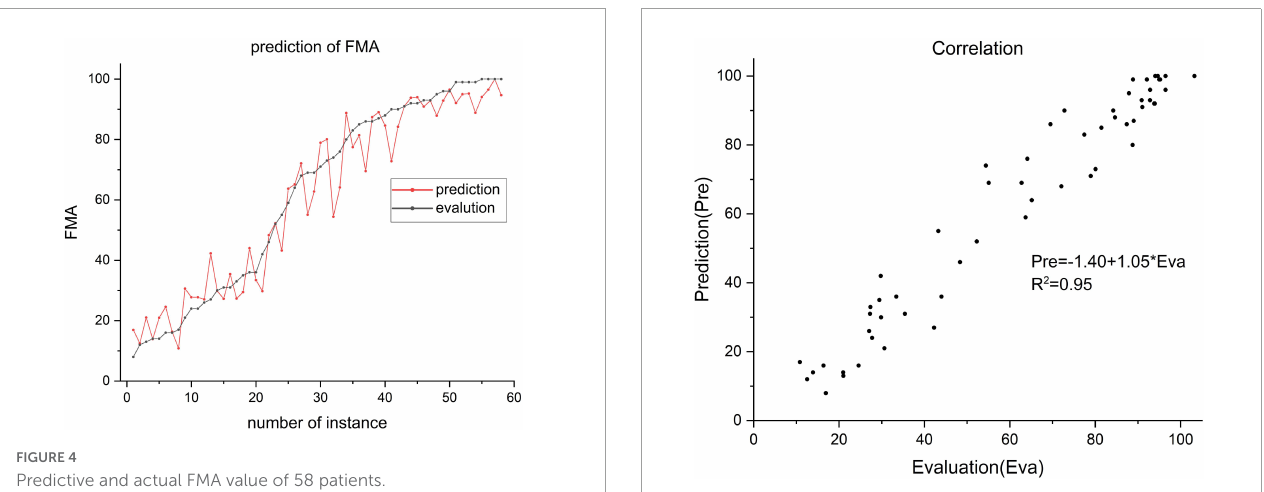
FIGURE5 Correlation between the predictive and actual FMA value of 58 patients. Prediction value = –1.40 + 1.05 × actual value, R 2 =